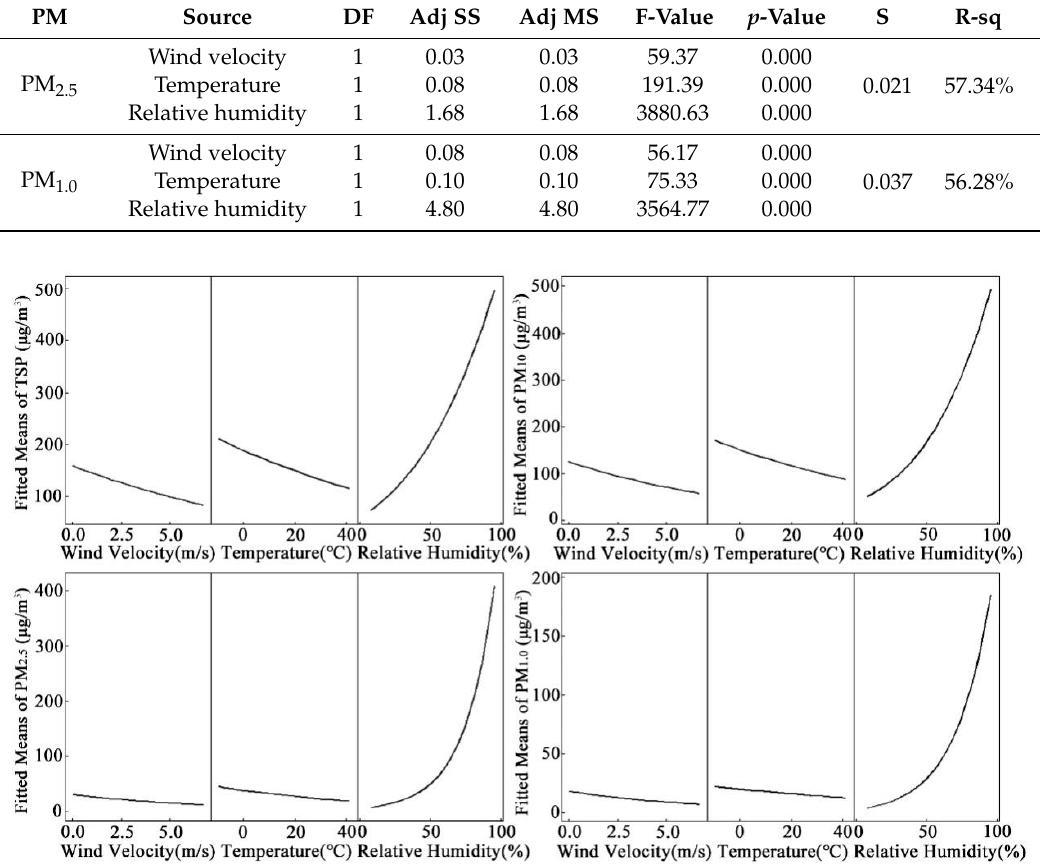
Figure 3. Relationship between meteorological factors and atmospheric suspended particulate matter